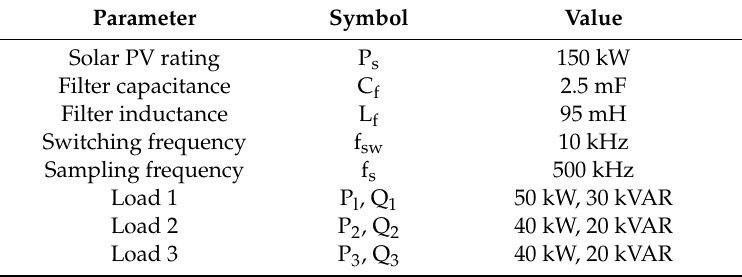
Table 1. Studied MG system parameters.